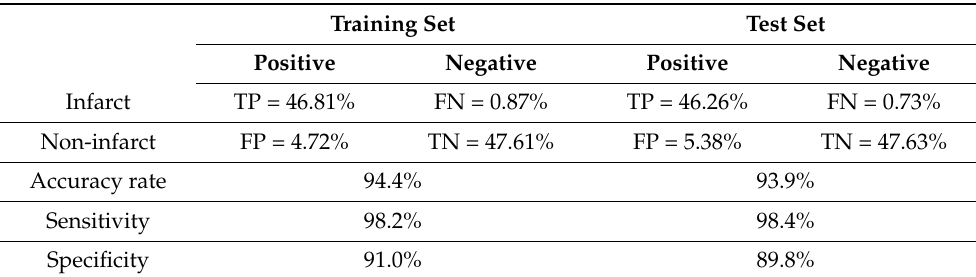
Table 1. Evaluation of the proposed